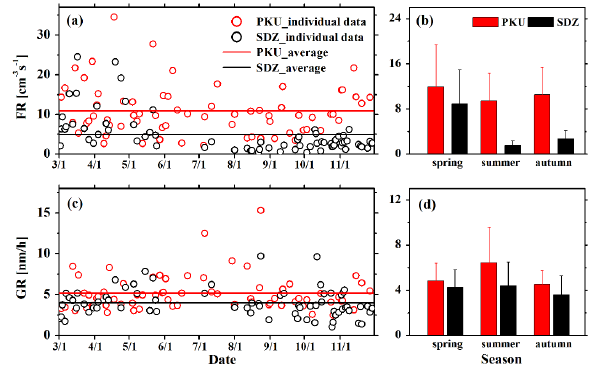
Figure 2. The variations of particle formation rates ( FR , a&b ) and growth rate ( GR , c&d ) at PKU (red) and SDZ 840 Fig. 2. The variations of particle formation rates (FR, a, b ) and (black) during measurement period. The bars in Figures (b) & (d) indicate the standard deviation. 841 growth rate (GR, c, d ) at PKU (red) and SDZ (black) during the measurement period. The bars in (b) and (d) indicate the standard deviation.